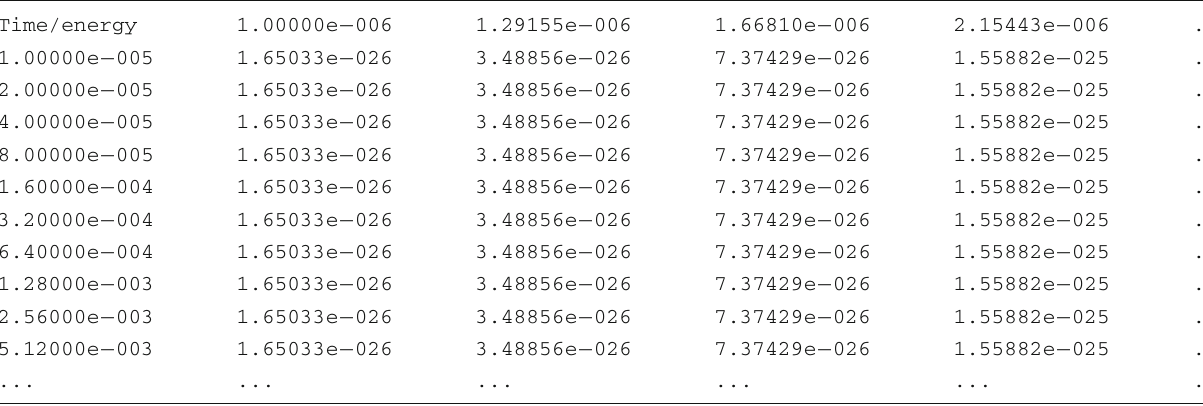
Table 7 Hawking primary spectrum as a function of time